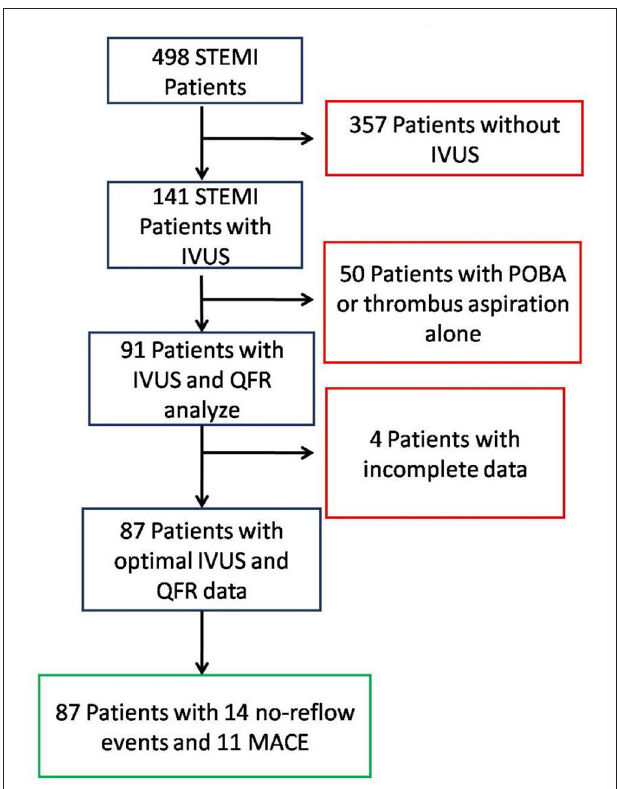
FIGURE 4 | Flowchart of study inclusion and